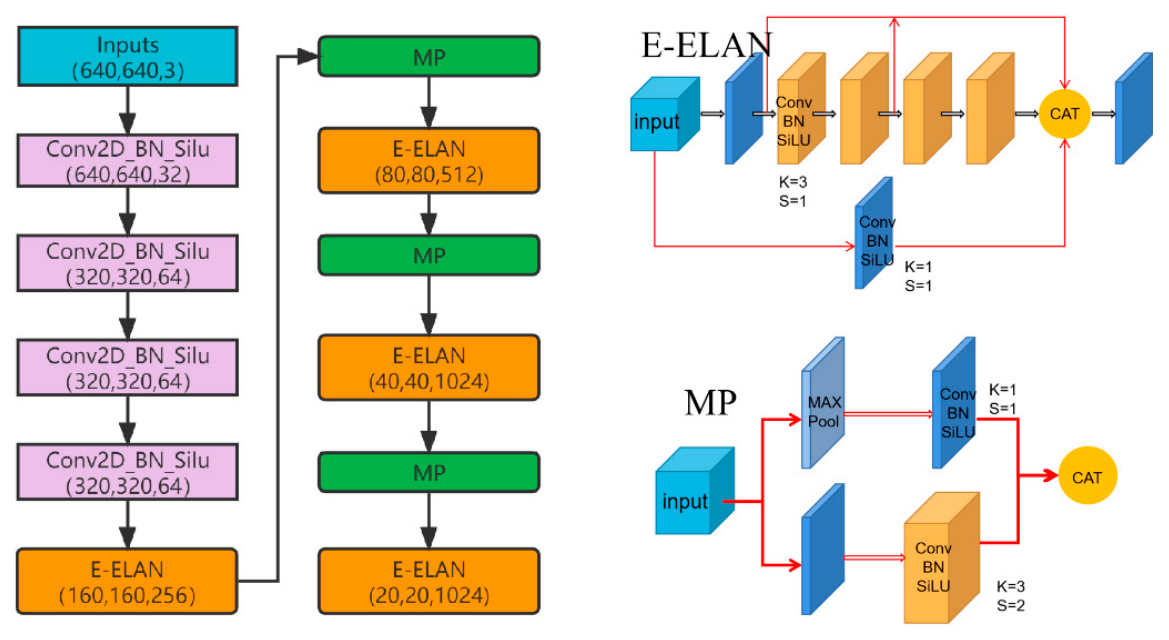
Figure 3. Detailed architecture of the FEN.